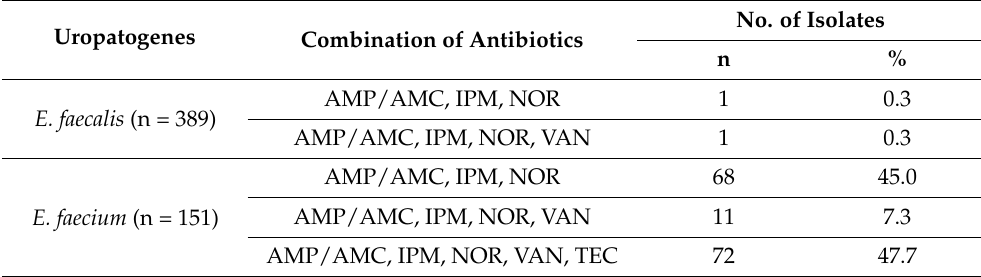
Table 5. Multi-drug resistance patterns of enterococcal strains isolated from the urine of patients hospitalized in Nephrology and Urology Clinics between 2016–2021 (n =